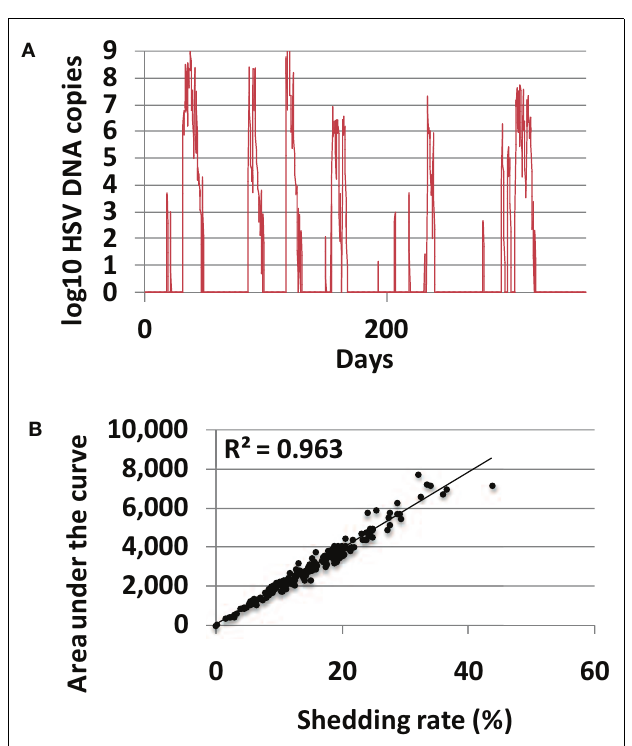
FIGURE 3 | Shedding rate is the most relevant measure of HSV-2 severity . (A) Typical model simulation demonstrating 365days of shedding. (B) Results from 200, 10-year model simulations, each with randomly selected parameter values. Shedding rate correlates tightly with a cumulative episode area under the curve indicating that shedding rate also highly predicts quantitative levels of viral shedding.